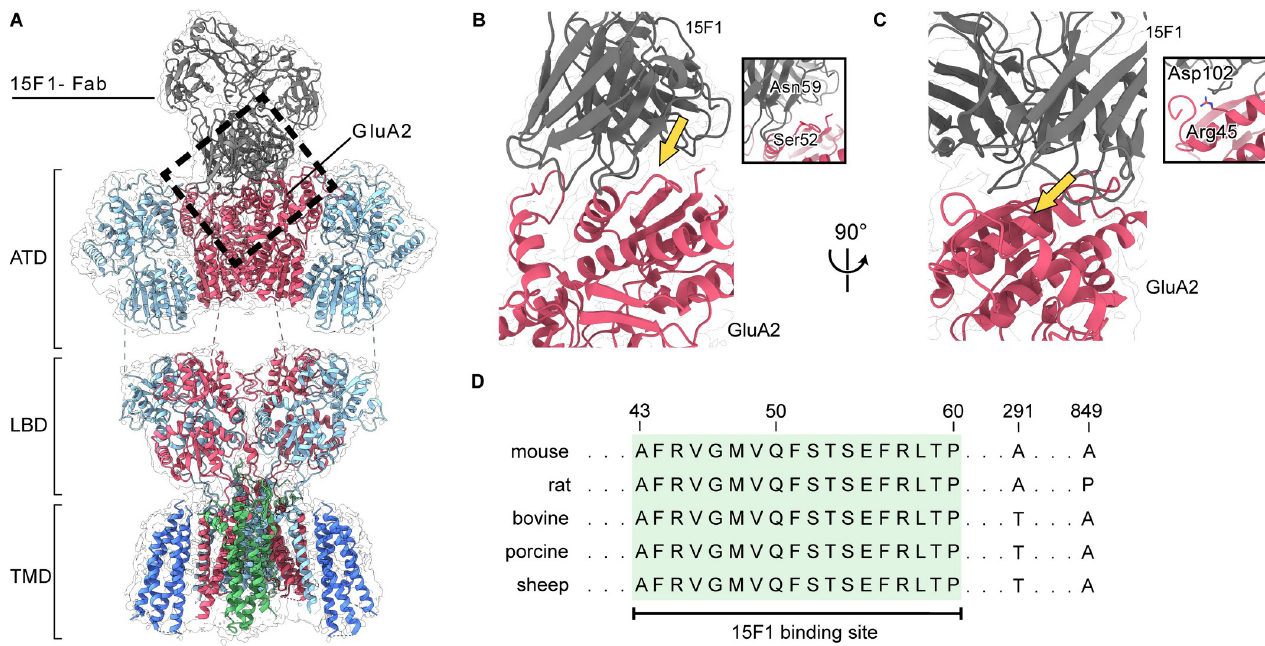
Fig 1. Conservation of the 15F1 Fab binding site. ( A ) Molecular model and cryo-EM map of the GluA1/GluA2 diheteromeric structure purified from mouse hippocampi (PDB: 7LDD) [41]. GluA1, GluA2, 15F1, TARP- γ 8, and CNIH2 are colored cyan, red, grey, green, and blue, respectively. The black dashed rectangle highlights the 15F1-Fab binding site on the ATD layer of GluA2. ( B, C ) Views of the interaction sites between 15F1 and GluA2. Insets: Close-up views of the regions indicated by the yellow arrows. ( D ) GluA2 sequence alignment of selected mammalian species. Conserved residues of the 15F1 binding region are highlighted in green. Unshaded residues denote sequence disparities between the selected